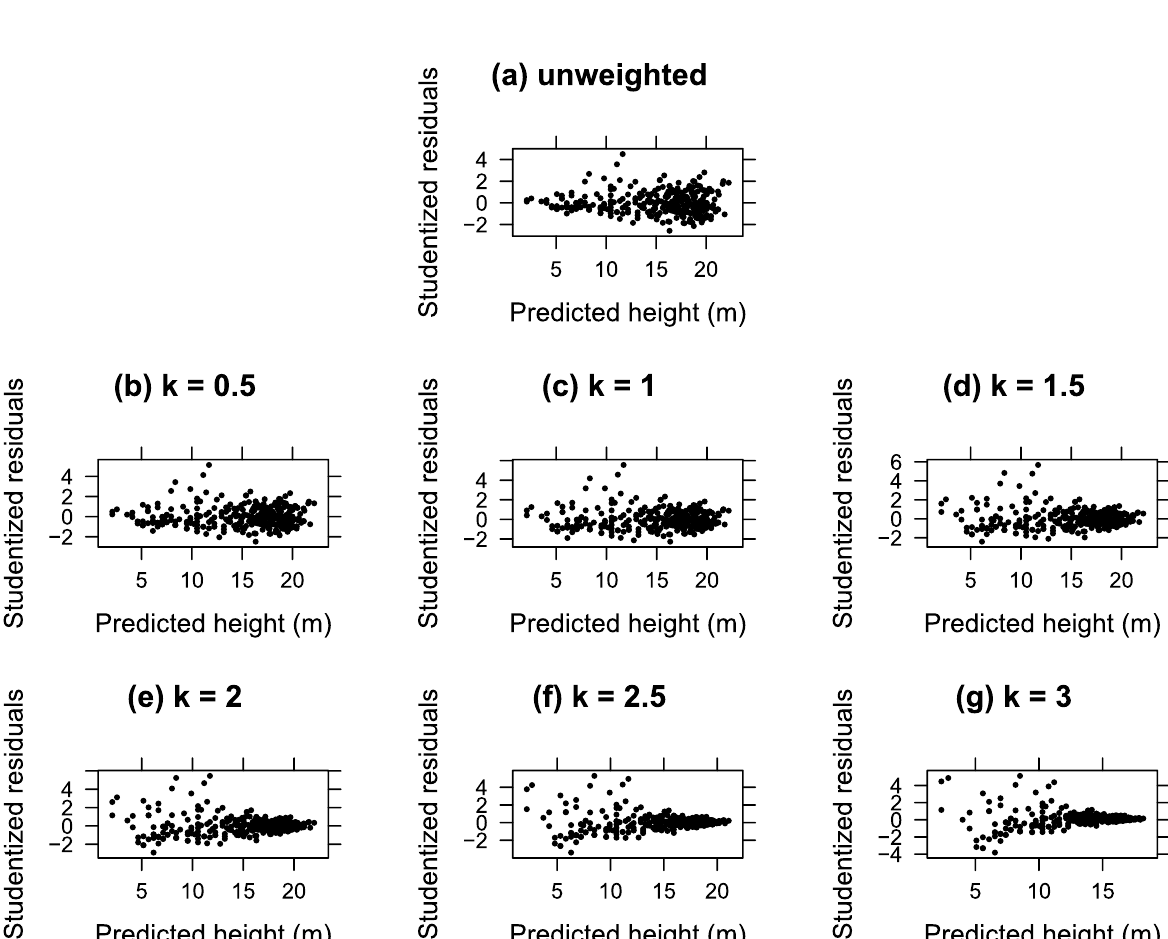
Fig. 14 The plot of studentized residuals against the predicted height for N. pumilio . The studentized residuals were obtained by fitting model SM1 NP ( a ) without weighting, with weight w i = 1 ∕ DBH k i , where ( b ) k